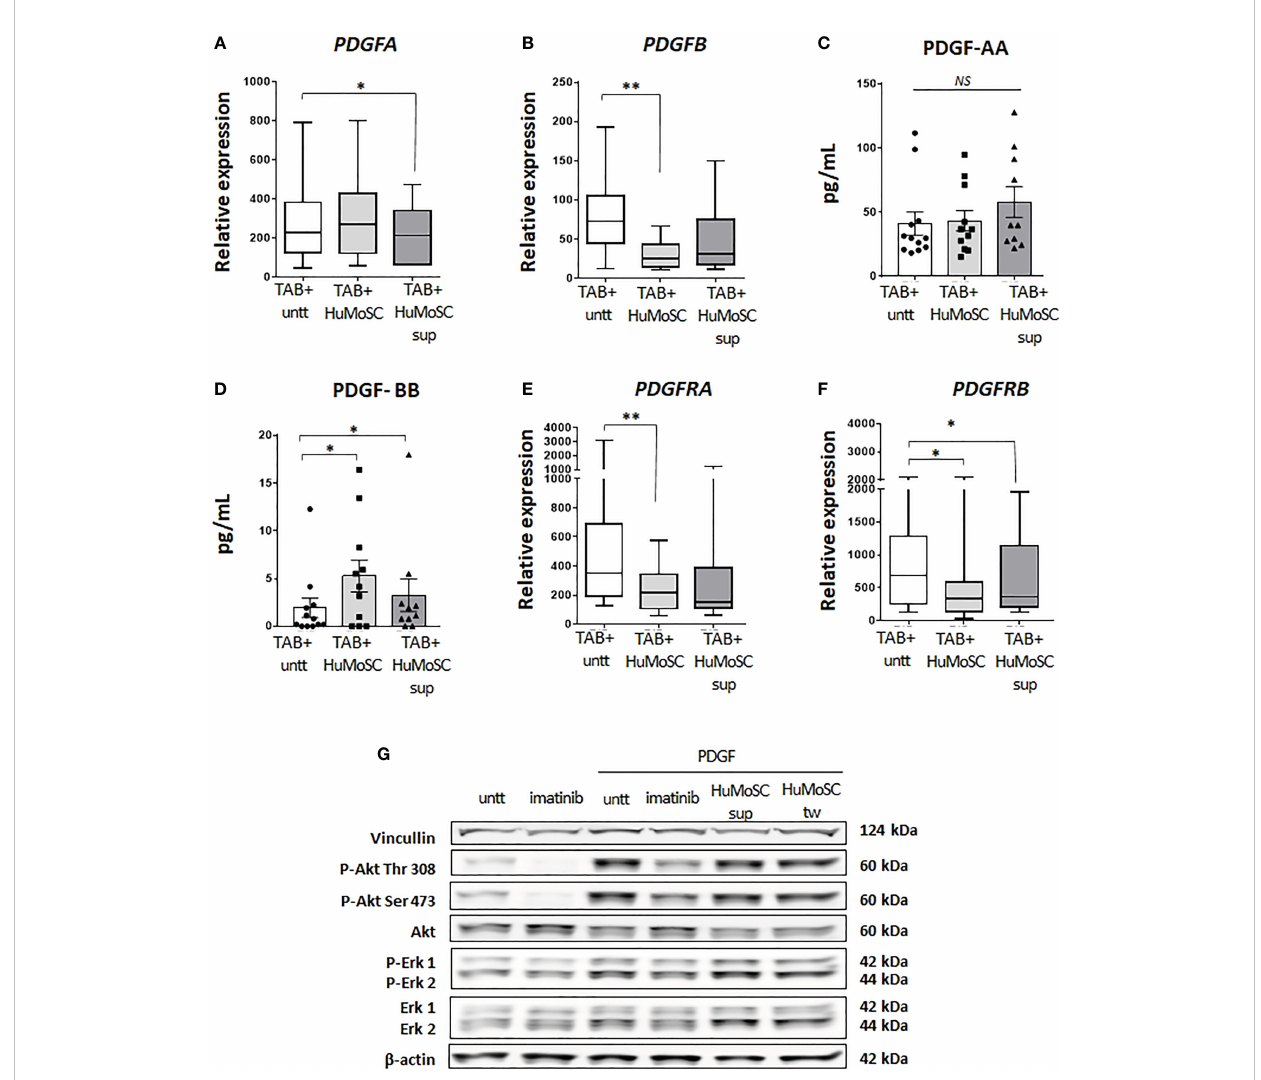
FIGURE 4 Effect of HuMoSC in the PDGF pathway. (A-D) effect of HuMoSC on the mRNA expression and production of PDGF after 5 days of ex vivo cultures of temporal arteries affected by GCA (TAB+, n=12) cultivated with or without HuMoSC (250.10 3 /mL) (n=11) or supernatant of HuMoSC (25%) (n=12). mRNA expression in TAB+ (A, B) and protein level in the supernatant of culture (C, D) . (E, F) mRNA expression of PDGFRA (E) and PDGFRB (F) after 5 days of ex vivo cultures of temporal arteries affected by GCA (TAB+, n=12) cultivated with or without HuMoSC (250.10 3 /mL) (n=11) or supernatant of HuMoSC (25%) (n=12). (G) study of the phosphorylation of Akt and Erk by western blot in primary cultures of temporal artery derived VSMC. VSMC werepre-treated with imatinib (1 µM,positive controlfor inhibition of phosphorylation), HuMoSC supernatant (25%) or HuMoSC (250.10 3 /mL separated by a transwell[tw]) during 1 hour and then cultivated alone or in the presenceof PDGF-AB (20 ng/ml) for 30 minutes. VSMC werecollected in 125 µL ofRIPA buffer before performing westernblots. b -actin andvinculin werestained as standards (representative resultof 2 independent experiments).Whisker boxes show the median (horizontal bar),the IQR (limits ofthe box) and extreme values (error bars).Histogramsshow the median (horizontal bar) and the IQR (errorbars). P is the result ofWilcoxontests. Signi fi cant results areshown( *P < 0.05,**P < 0.01 , NS, Not Signi fi cant) otherwise non-signi fi